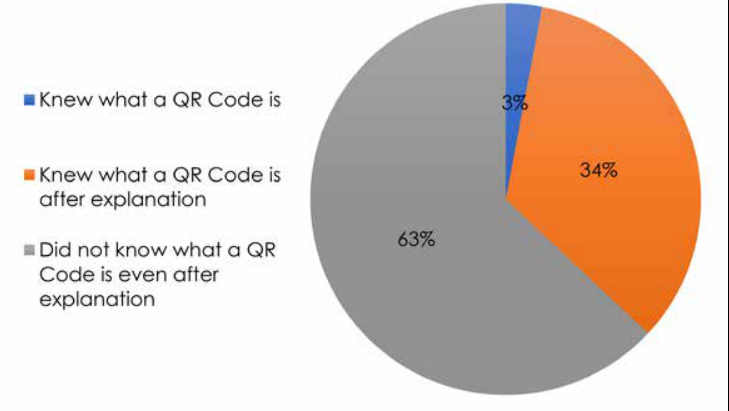
Figure 3: Interviewees’ view on QR